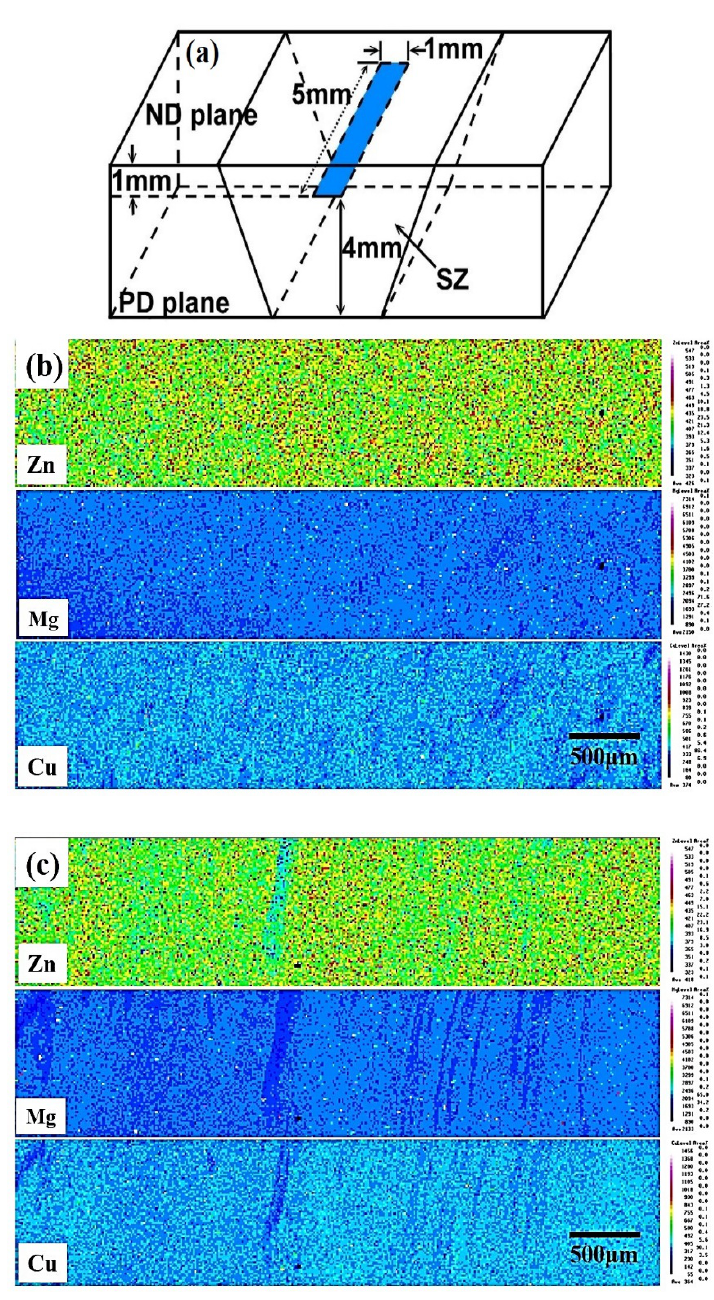
Figure 6. EPMA of the FSP specimens: ( a ) location of the sample; ( b ) 1230 rpm without FSIB structure; and ( c ) 1670 rpm with FSIB structure.